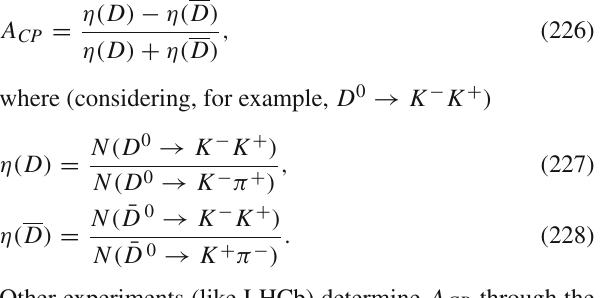
In each experiment, care must be taken to correct